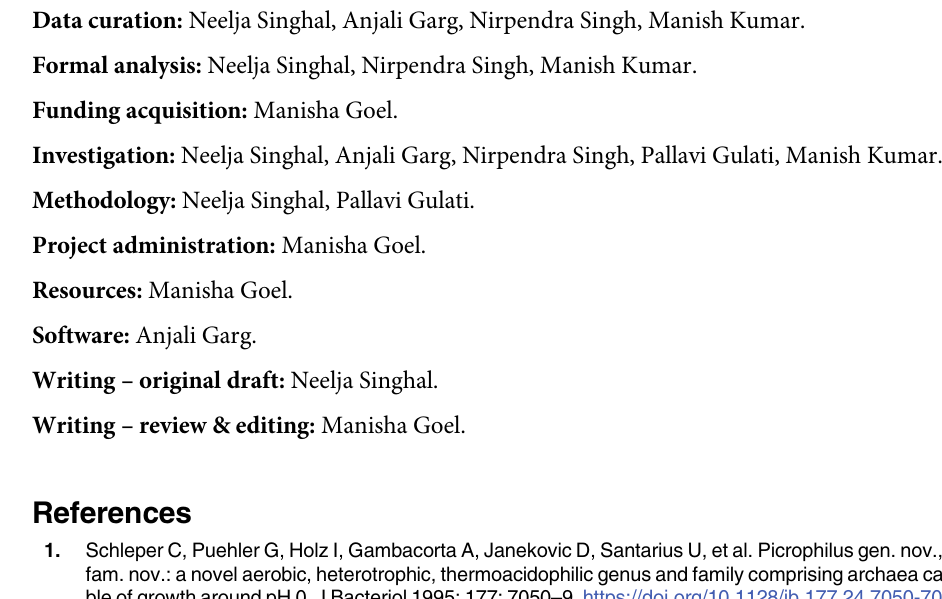
S1 Fig. Circos plot showing the domains present in the 30 secretory proteins of P . torridus . S1 Table. P . torridus secretory proteins, PDB BLAST hits with percentage identity. S2 Table. Prediction efficacy of various SPPs in identifying SPs in P . torridus secretome identified in three independent